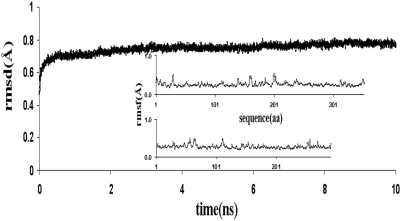
MD simulation RMSD and RMSF profiles.Over a 10 ns span the RMSD remains very low, below 0.75 Å for trace alpha carbons of the PECr complex. The RMSF profile over the sequence, shown in the inset, indicates that the RMSD is mainly due to the loop flexibility.